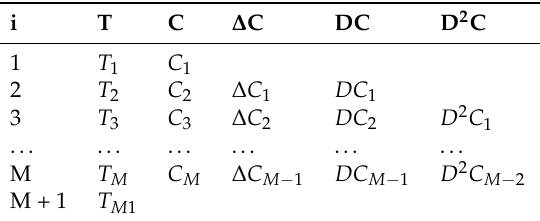
Table 1. Connection between the time series